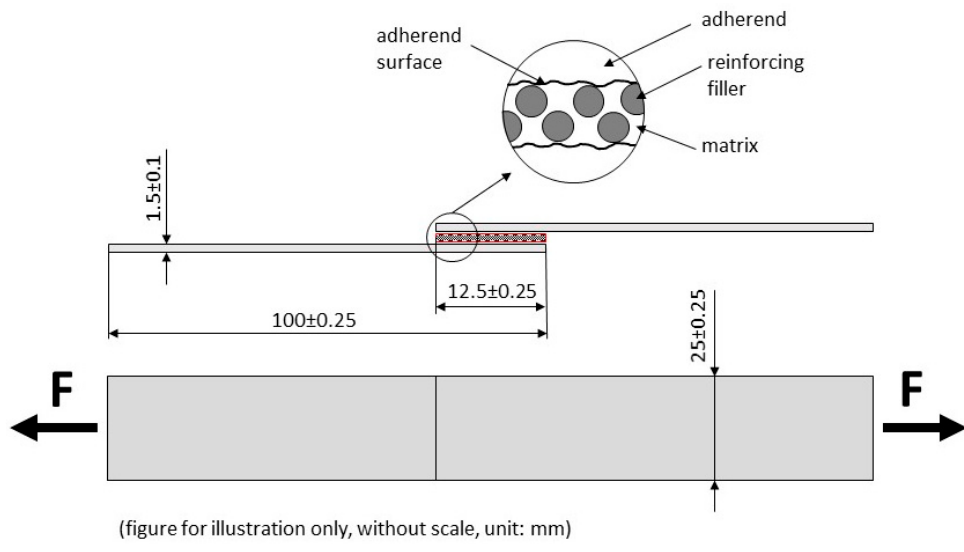
Figure 3. Scheme of adhesive bond according to EN 1465 [52].